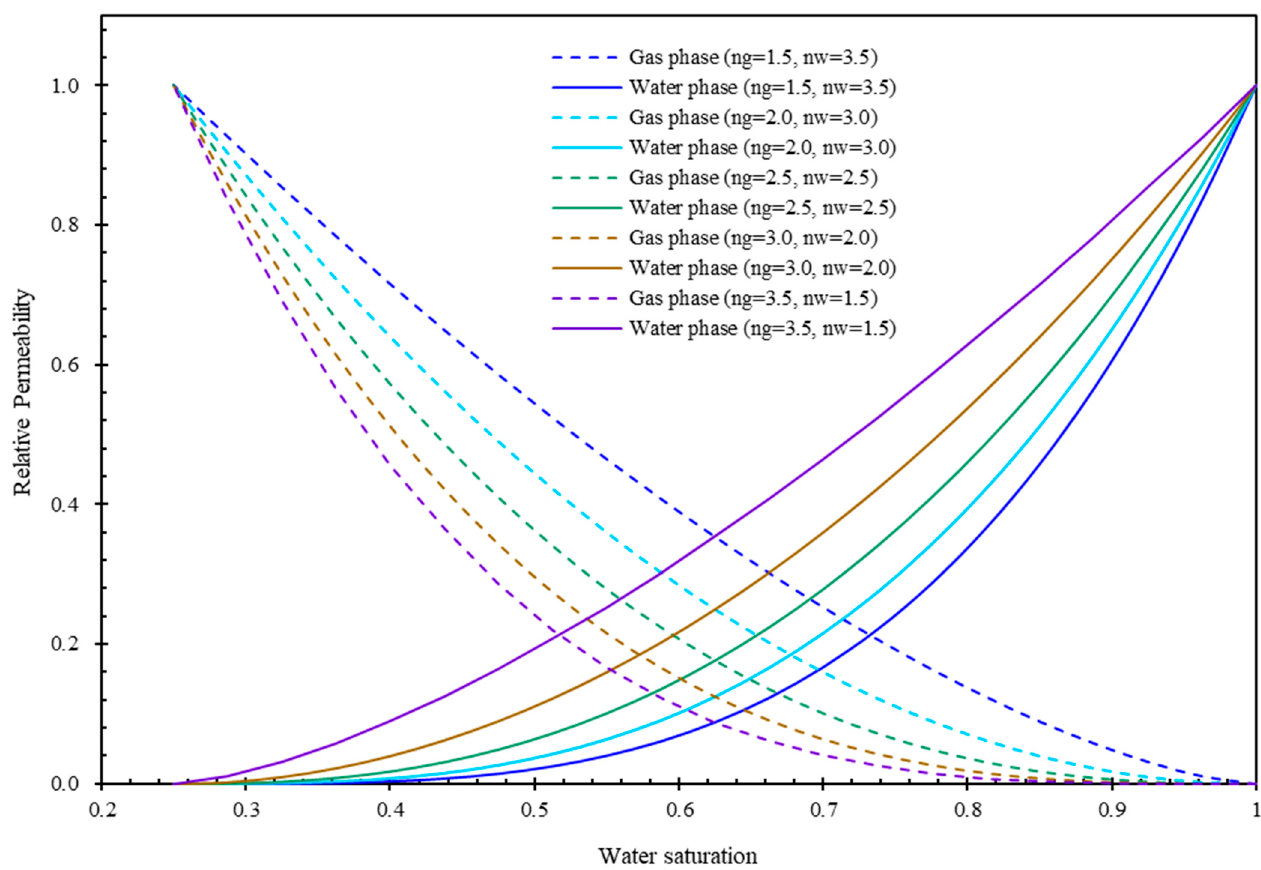
Figure 7. Different gas–water relative permeability curves.